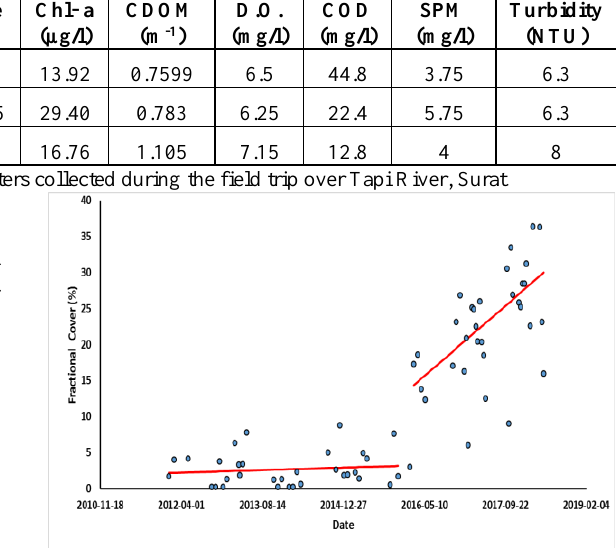
Figure 5. Increasing trend of Macrophytes in Tapi River (close to Surat) using multi-year satellite